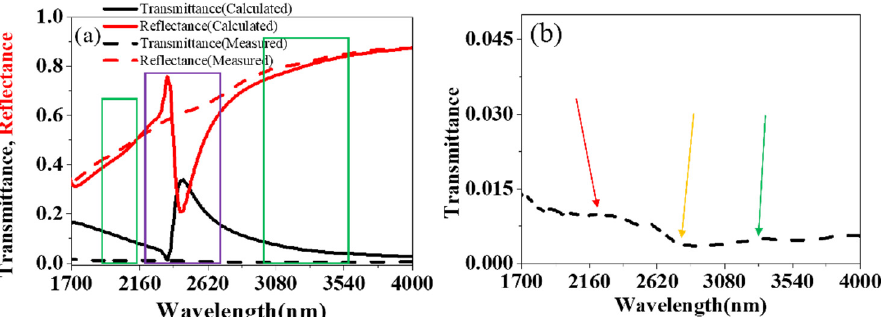
Figure 13. ( a ) The calculated and measured of transmittance and reflectance of the fishnet MDM, the green frames represent the position of magnetic resonances and the purple frame represents the position of electric resonance. ( b ) The magnified curve of the measured transmittance, the red arrow points out the location of magnetic resonance at 2072 nm, the yellow arrow points out the location of electric resonance at 2300 nm, and the green arrow points out the location of magnetic resonance at 3225 nm.